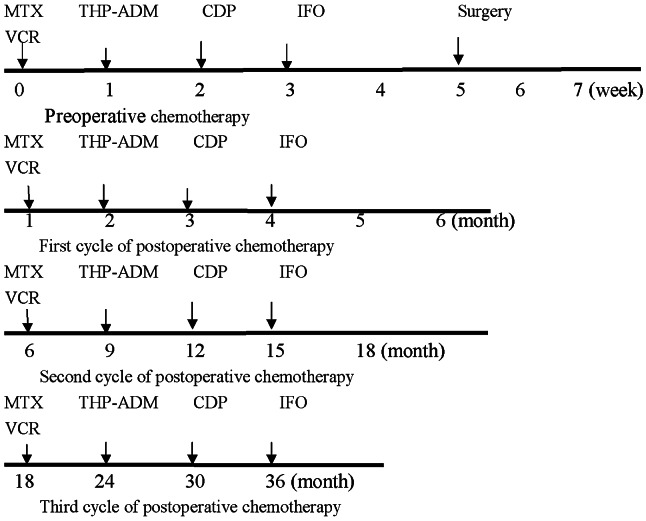
Chemotherapy regimen. MTX, methotrexate; VCR, vincristine; THP-ADM, pirarubicin; CDP, cisplatin; IFO, cyclofosfamide.